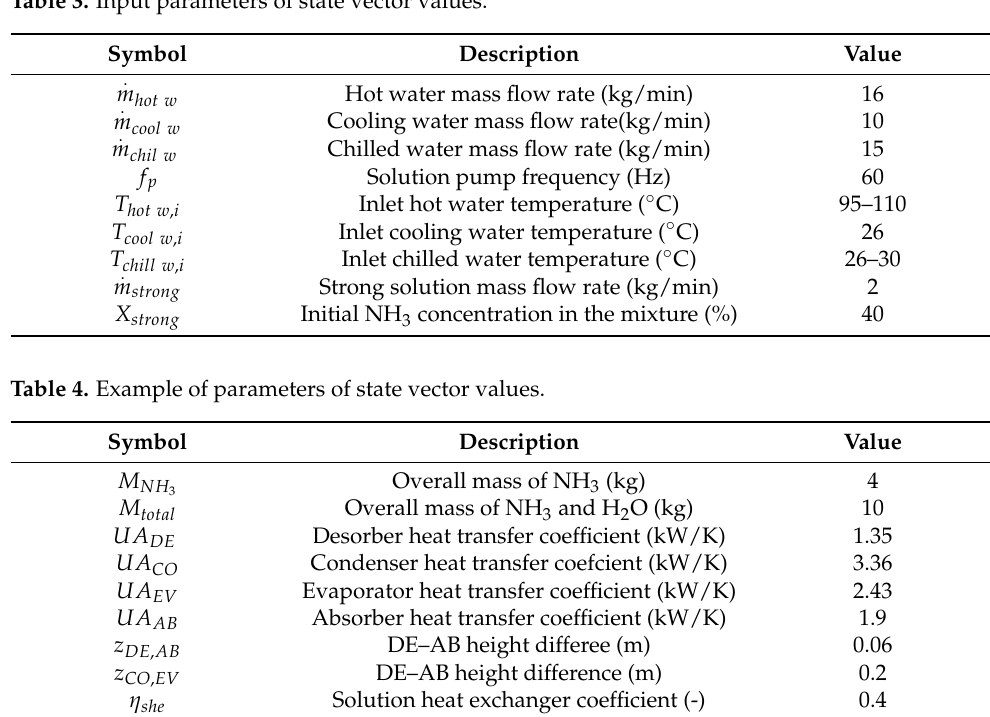
Table 3. Input parameters of state vector values.